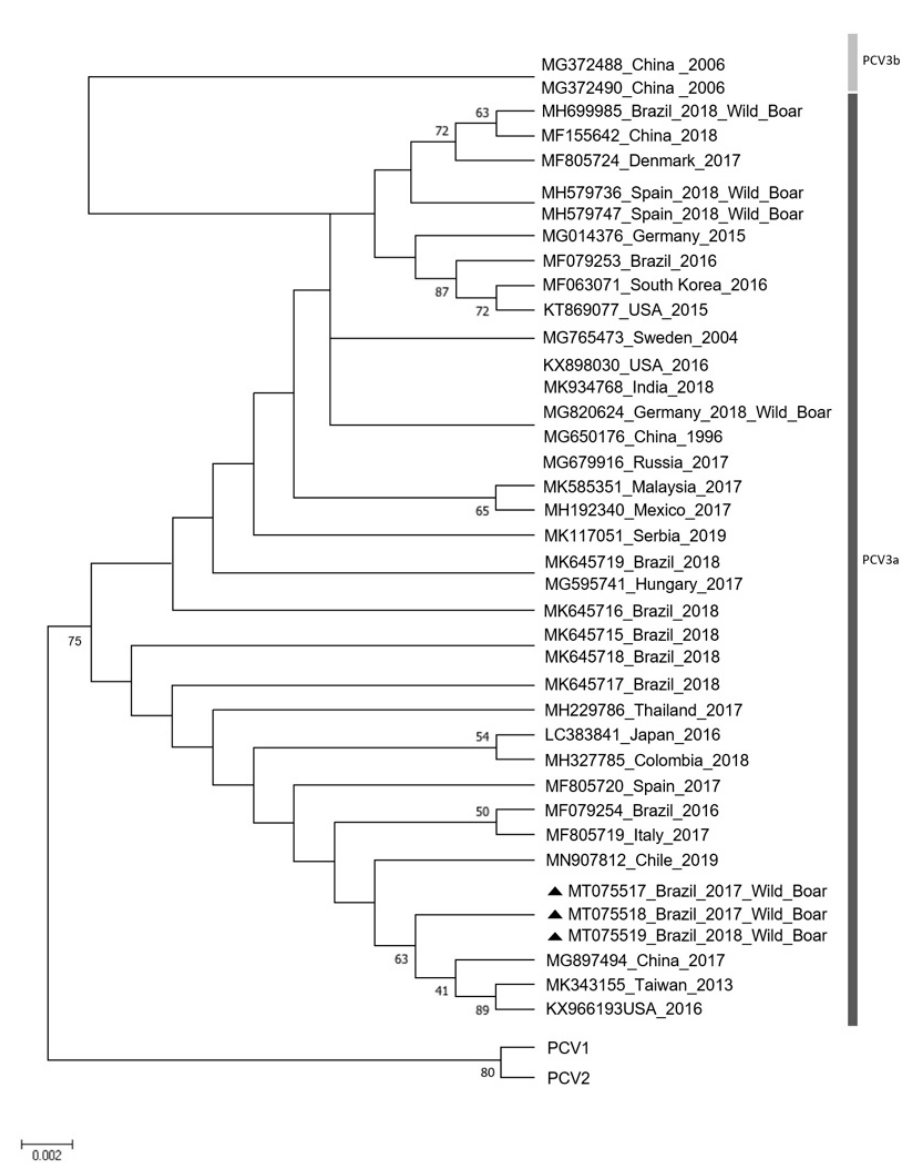
Figure 1. Phylogenetic tree of the full-length PCV-3 genome using the neighbor-joining method. Bootstrap values were determined with 1000 replicates, and the evolutionary distances were computed using the Tamura 3 parameter model. Evolutionary analyses were conducted with MEGA 6.0 software [29]. The three Brazilian PCV-3 field strains from free-living wild boars are labeled with a solid black triangle. The sequences of PCV-1 and PCV-2 were used as outgroups.